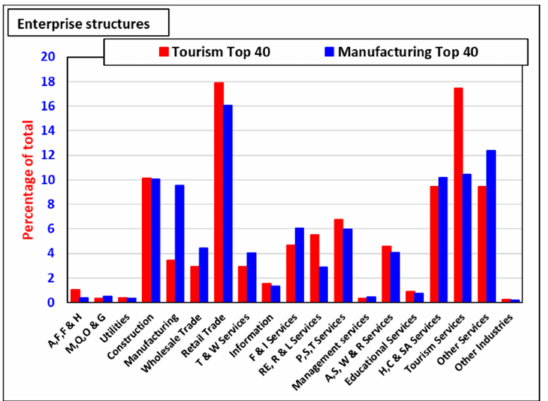
Figure 12. The enterprise structures of the top 40 tourism and the top 40 manufacturing United States micropolitans. The structure reflects the proportion (%) of the total sector enterprise numbers relative to the total group enterprise numbers. The explanation of the abbreviations of the business sectors is presented in Table 1.